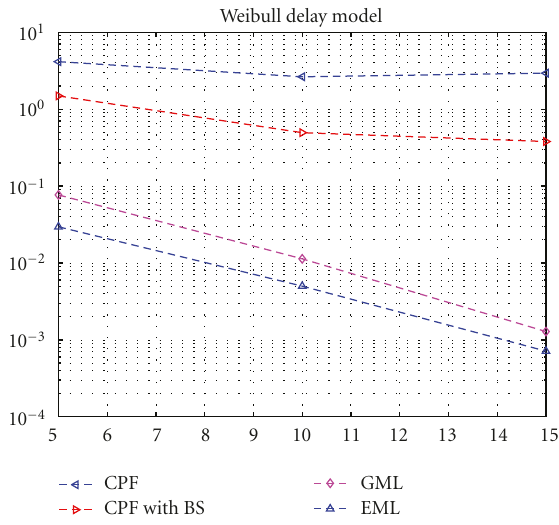
Figure 9: MSEs of clock o ff set estimators for Weibull random delay = 2 and α = 6, β = 2] and 2 exchange message [ α 1 = 2, β 2 1 2 errors occur.